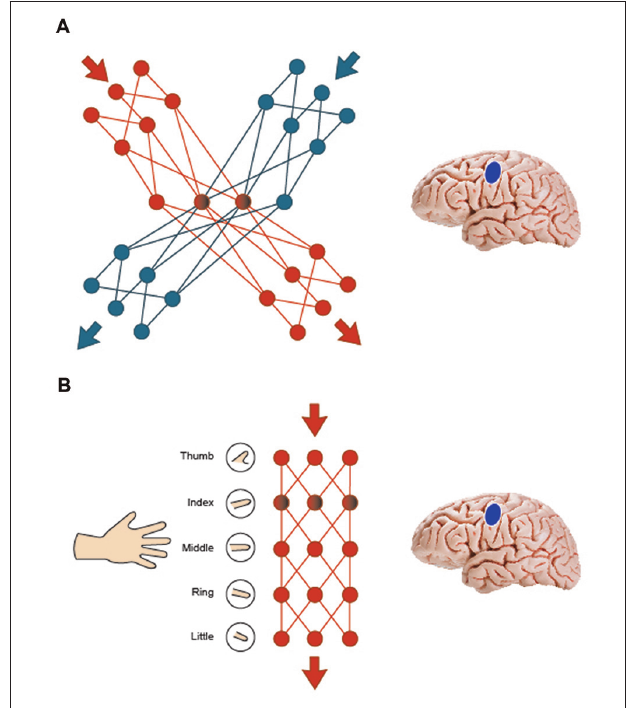
FIGURE 5 | Interference and facilitation effects are illustrated using synfire chains (A) two similar motor sequences incompatible with each other inhibit each other by way of inhibitory connections in cortex. Complex motor movement and memory for action words compete for common processing resources in the sensorimotor cortex, resulting in local inhibition between overlapping and adjacent memory and motor circuits. (B) A simple motor program embedded in a more complex motor program co-activates the more complex one to a degree, resulting in priming effects. When simple finger alterations are combined with action word memory, activation from finger movements spreads to motor and memory circuits within the motor network and this co-activation facilitates memory for action